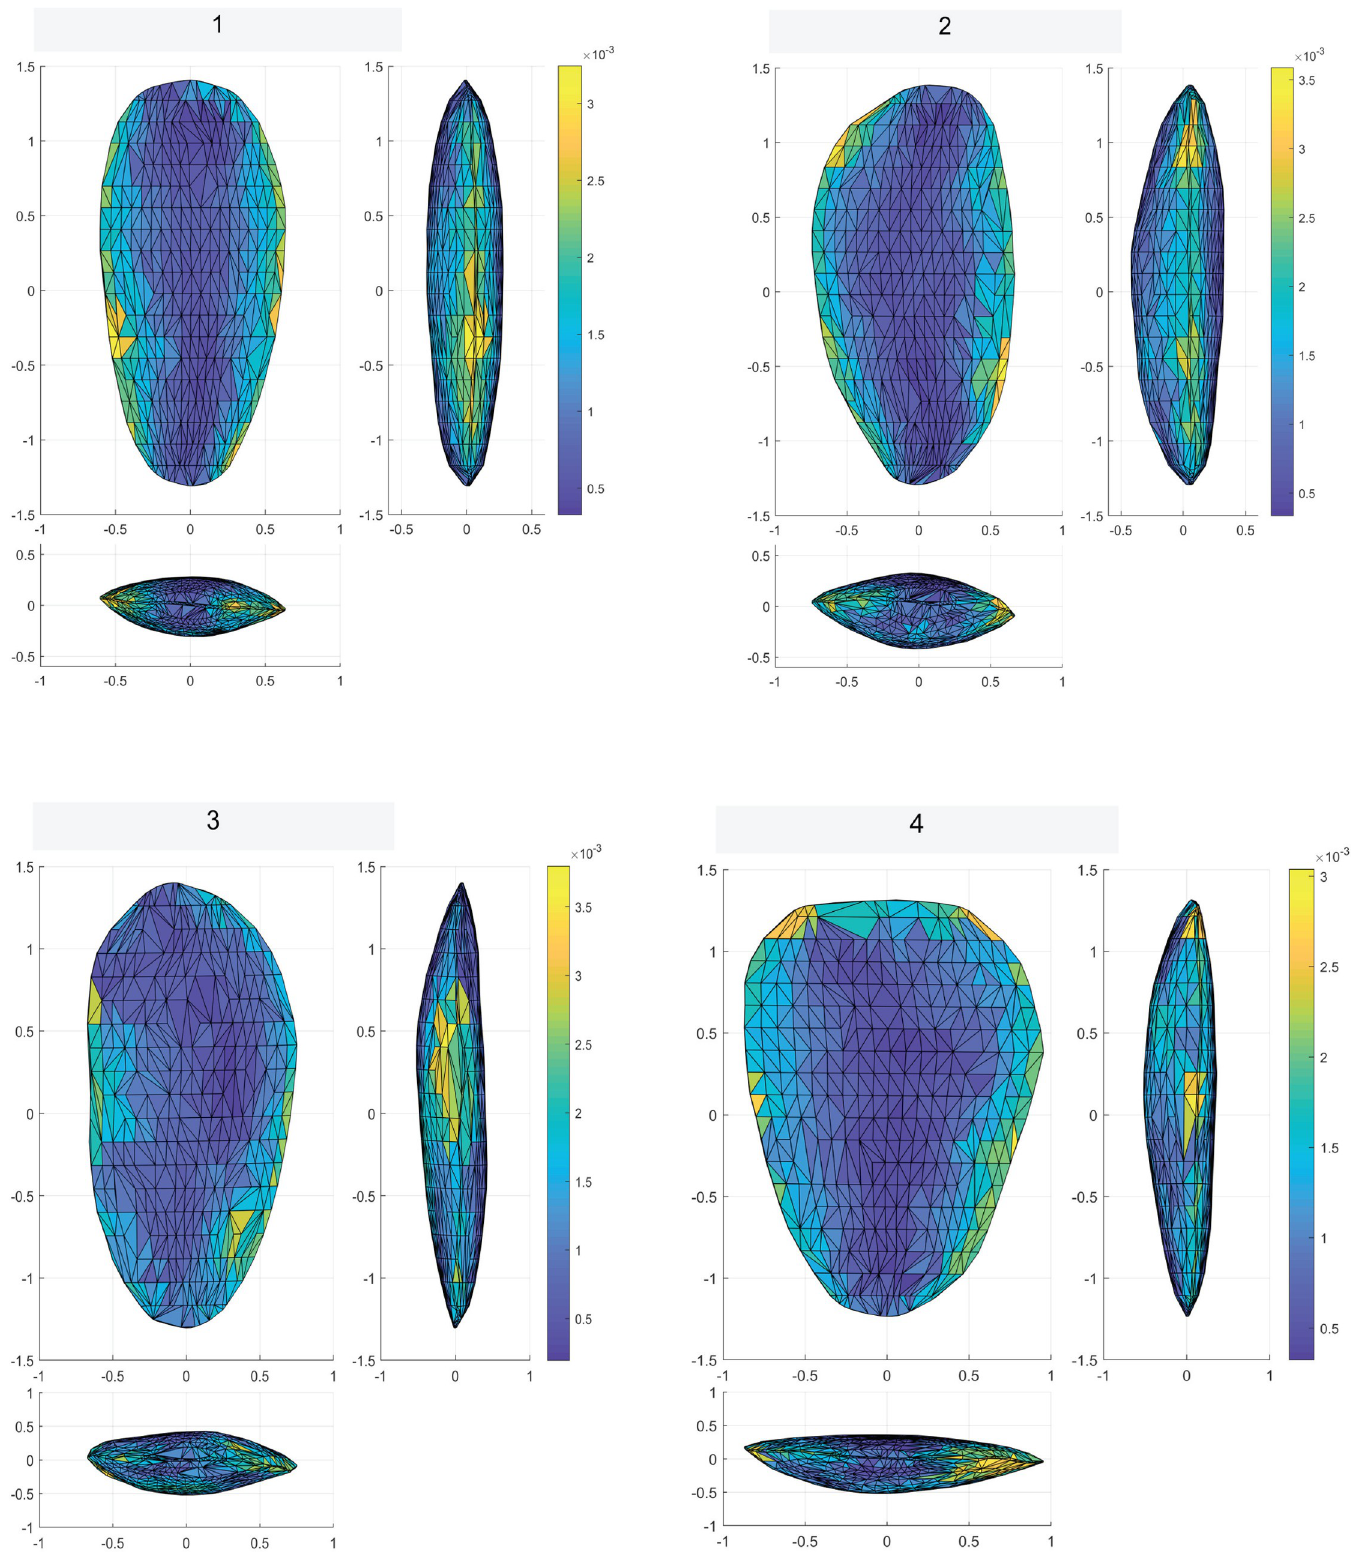
Fig 38. Mean shapes (central tendencies) of clusters 1 (A), 2 (B), 3 (C), and 4 (D). Color scales reflect the proportional spatial distribution of variability in each cluster (i.e., the areas that are most variable). https://doi.org/10.1371/journal.pone.0265727.g038 PLOS ONE | https://doi.org/10.1371/journal.pone.0265727 March 24,